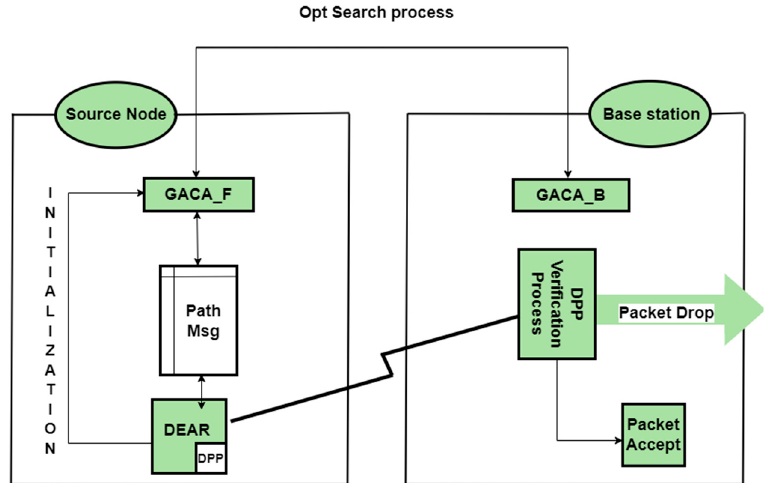
Figure 21. The architecture of the proposed algorithm [14].